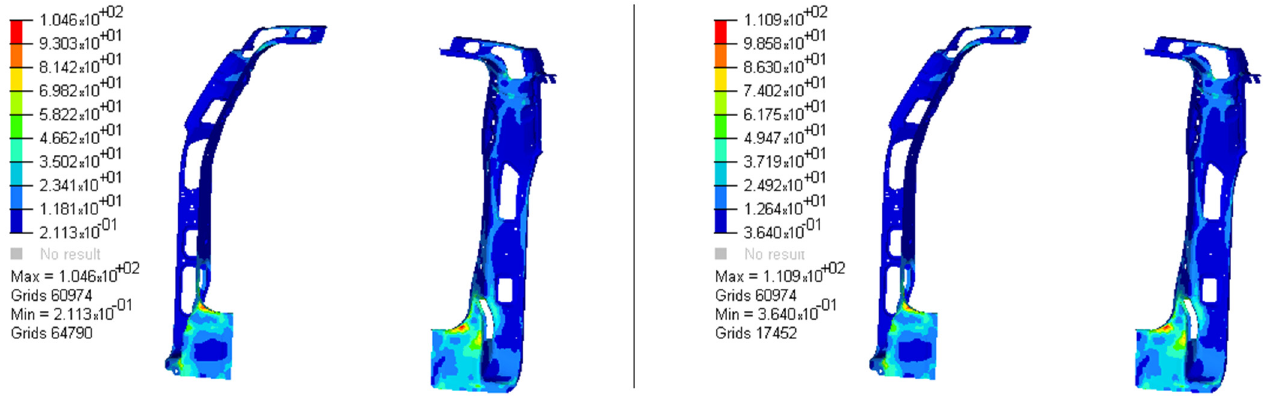
Figure 14. Maximum stress under torsional critical load on the adjusted FE model ( left ) and the adjusted optimized FE model ( right ).